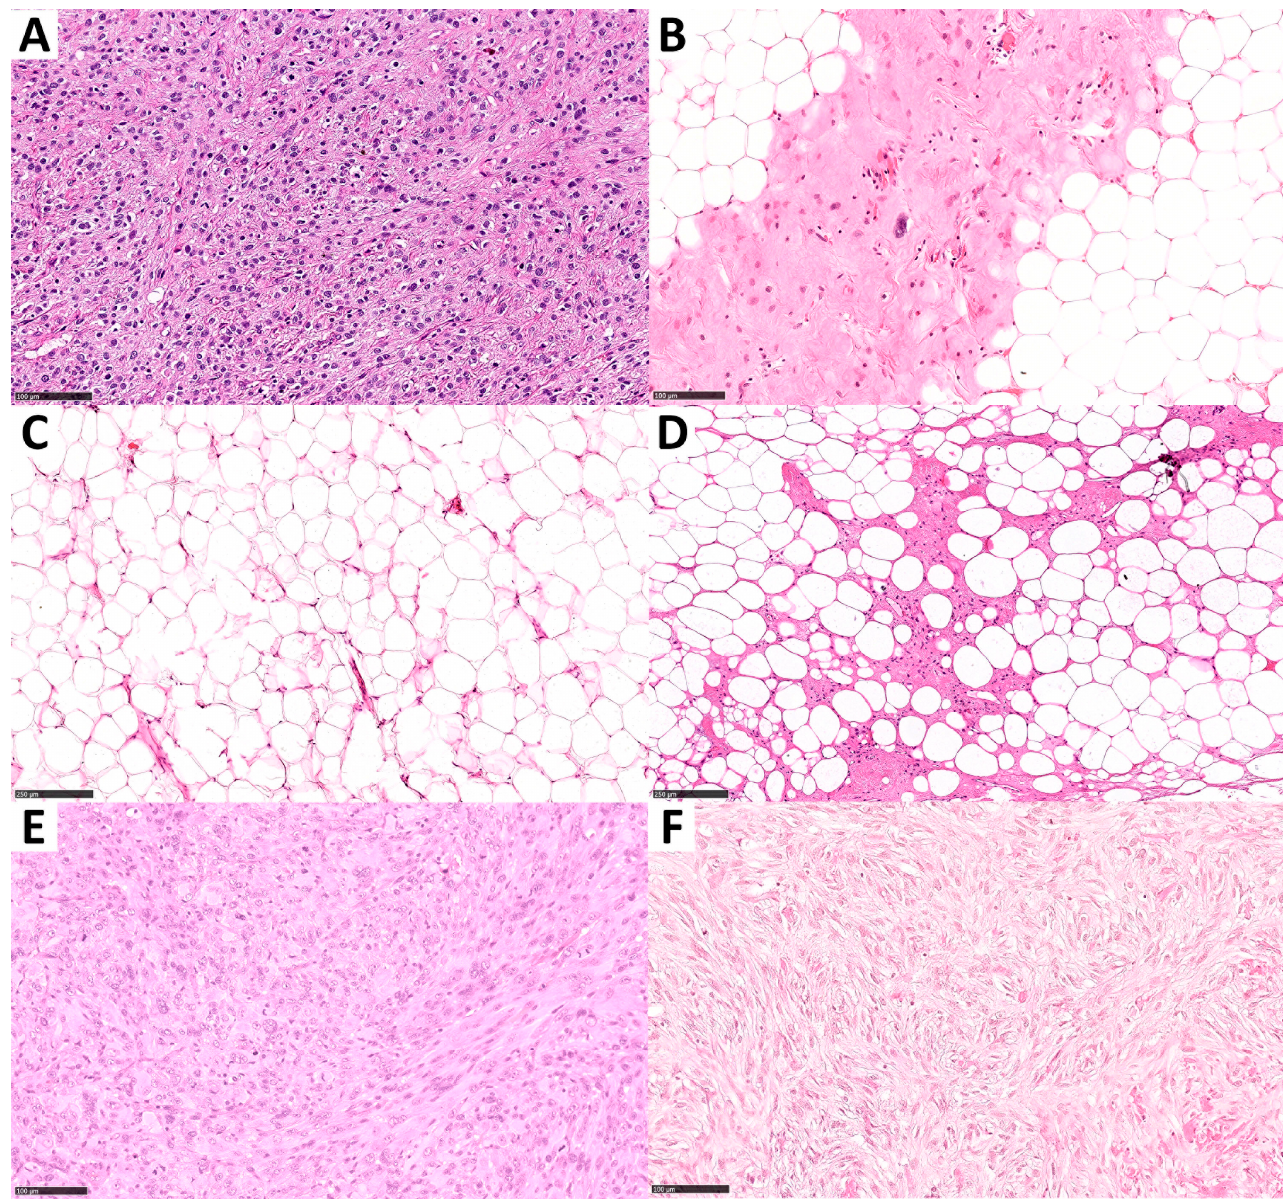
Figure 6. Matched histopathological features of the representative samples presented in Figure 2. Hematoxylin and eosin stain were used to evaluate the histological characteristics of the analyzed tumors and select representative areas for FISH analysis. ( A ) An MDM2 -amplified DDLPS showing only focal lipomatous areas (the corresponding MDM2 amplification pattern is shown in Figure 2A). ( B ) An MDM2 -amplified WDLPS (the MDM2 amplification pattern of this cases is represented in Figure 2B); ( C , D ) Representative images of two lipomas that were analyzed for MDM2 amplification (the corresponding negative MDM2 FISH patterns are represented in Figure 2C,D); ( E ) A non- MDM2 -amplified undifferentiated pleomorphic sarcoma with giant cells (the corresponding MDM2 and EGFR FISH patterns are represented in Figure 2E (including the top inset) and Figure 2F, respectively); ( F ) An MDM2 -amplified DDLPS with scattered giant cells (the corresponding MDM2 FISH pattern is provided in Figure 2E (bottom inset)).